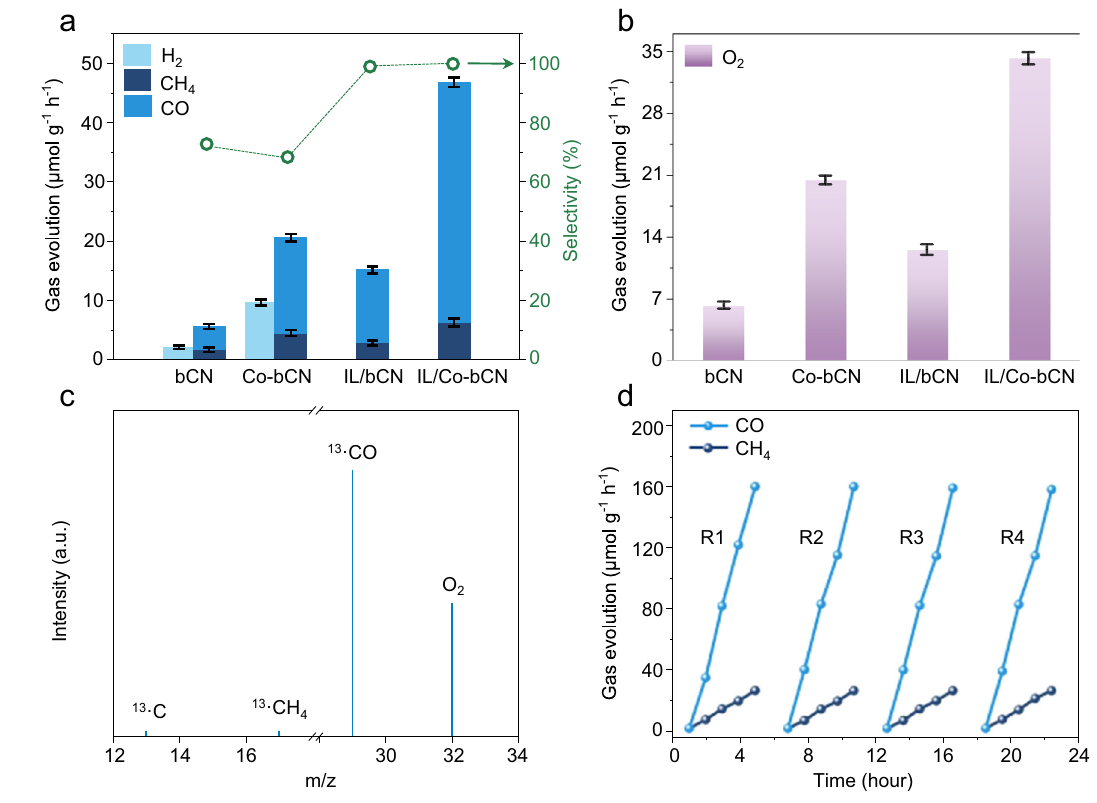
Fig. 2 | Photocatalytic CO 2 conversion to valuable chemicals. a Photoreduction of CO 2 and protons on bCN, IL/bCN, Co-bCN, and IL/Co-bCN under UV – vis light irradiation. Right Y-axis (green) indicates the product selectivity for CO 2 photo- reduction. b OxygenevolutiononbCN,IL/bCN,Co-bCN,andIL/Co-bCNduringCO 2